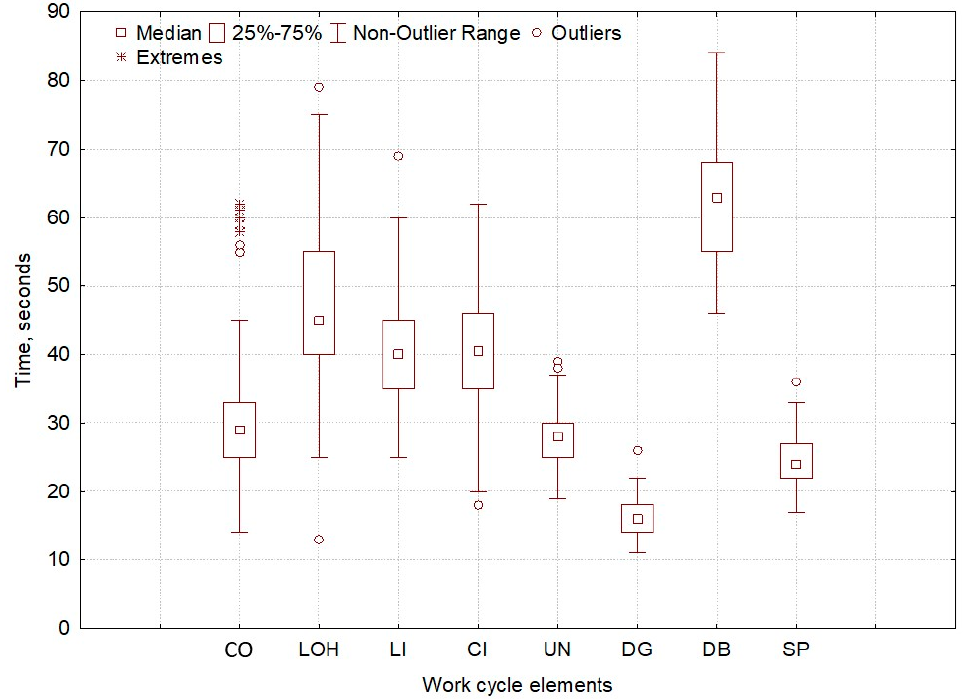
Figure 5. Elemental time consumption of processor tower yarder.